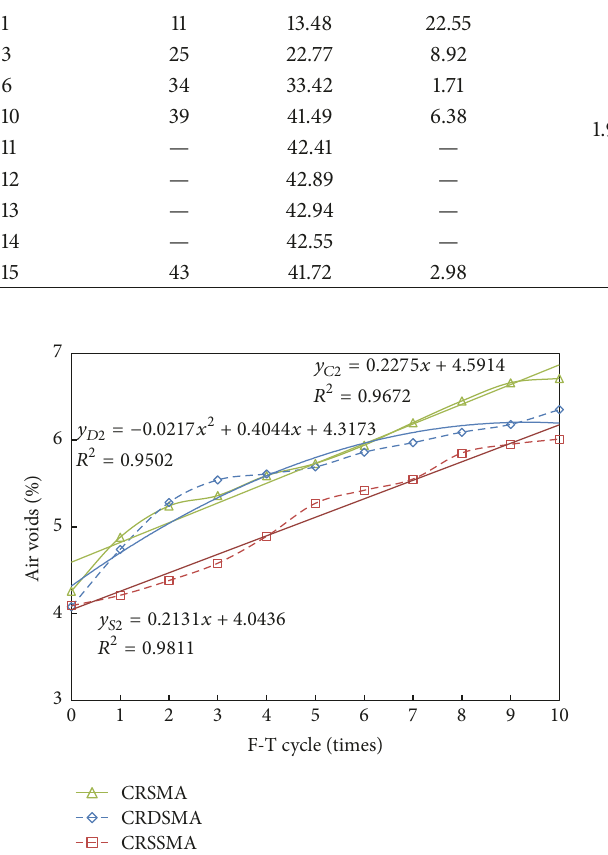
Figure 10: Regression models of air void for CRSMA, CRDSMA, and